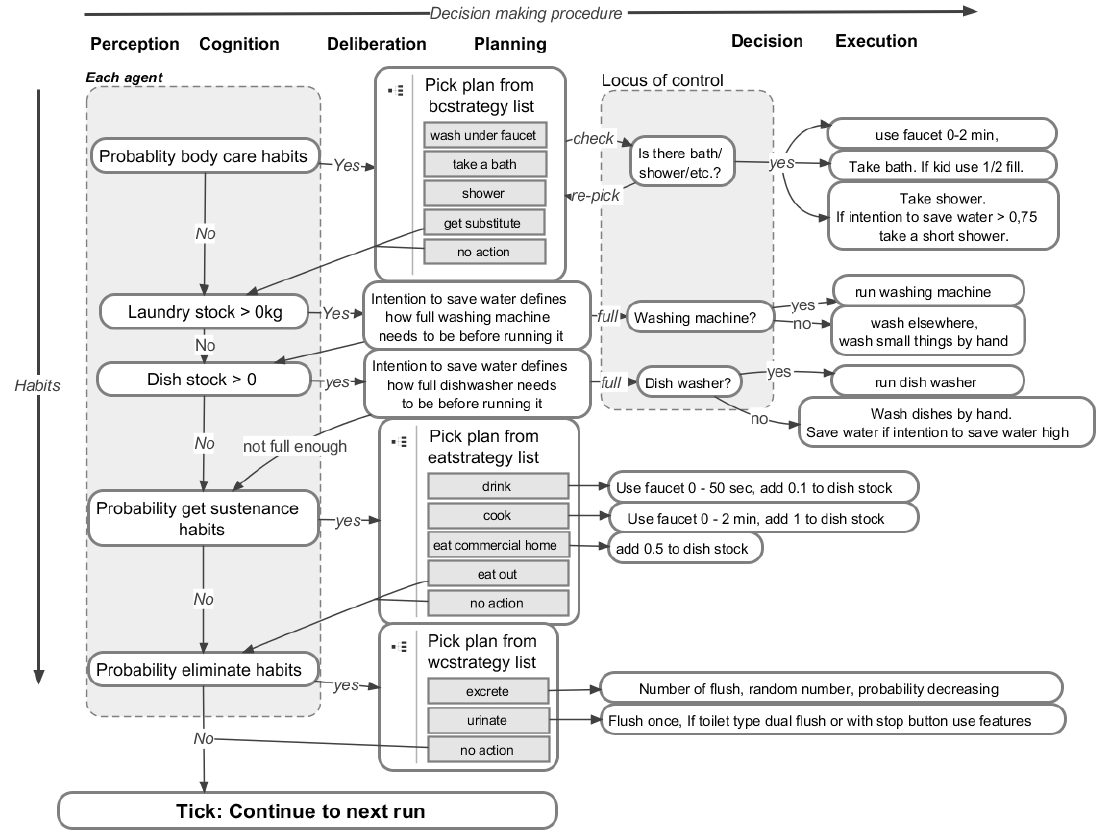
Figure 4. Graphical representation of the agent decision-making process in the model to execute each of the water use habits: clean body, get clean clothes, wash dishes, get sustenance and eliminate. An agent perceives its needs and desires, plans which actions to take, checks the household locus of control and intention to save water, and finally decides and